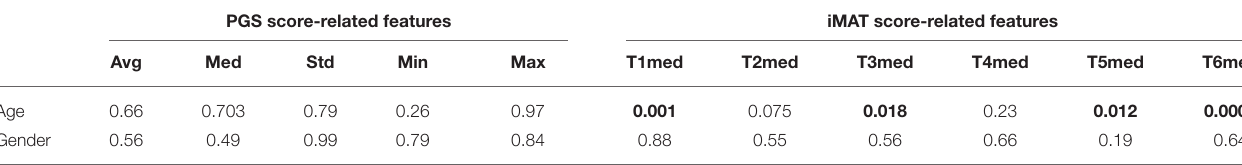
TABLE 2 | Estimated p -values from the demographics linear regression analysis.